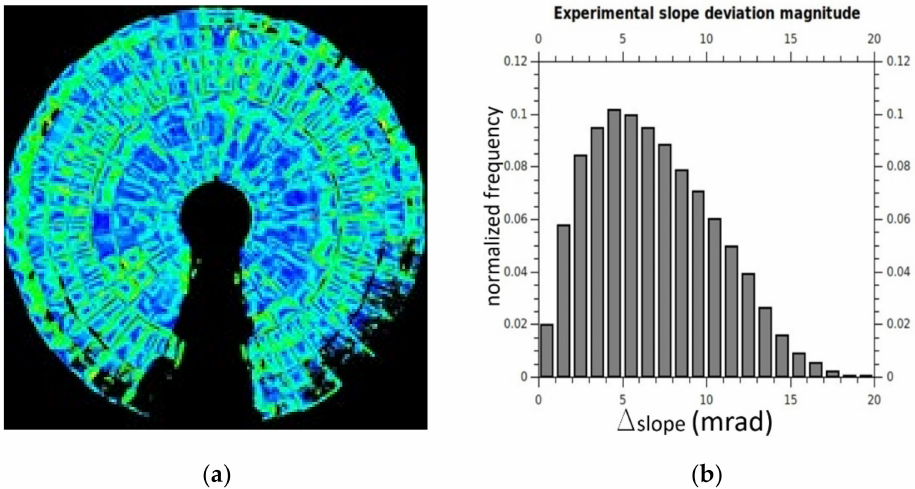
Figure 2. ( a ) Contour map of the experimental magnitude of the slope-deviation ∆ slope. Black = not sampled, pixel-colour from blue to red corresponds to slope-deviation from 0 to 20 mrad [18]; ( b ) Distribution of the slope-deviation magnitude